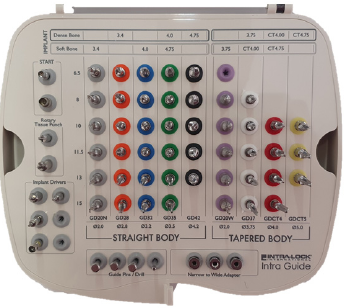
Figure 13. Intra-Guide Surgical Kit.